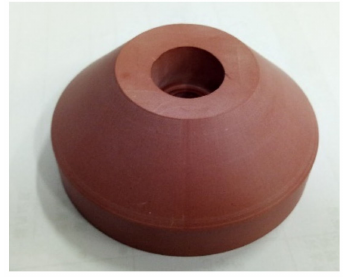
Figure 10. The finished